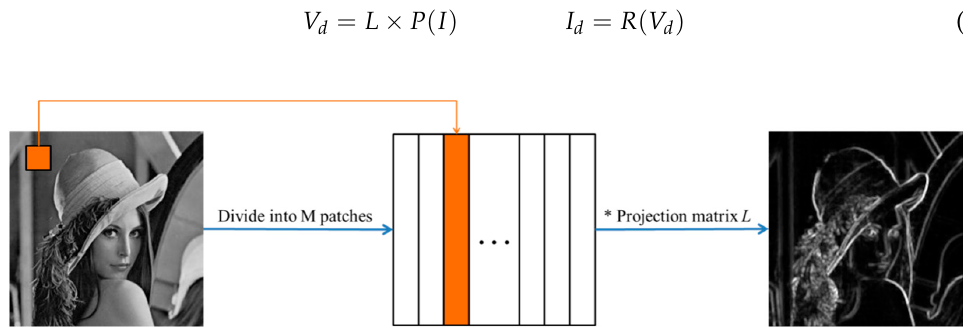
Figure 3. The process of image saliency features extracting based on LatLRR